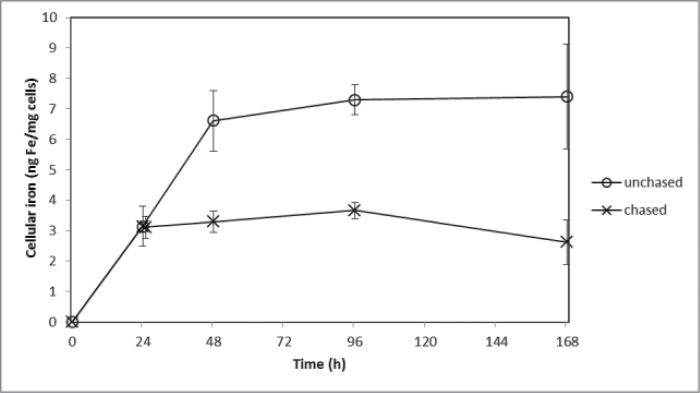

55Fe uptake (internalized Fe) after washing with the Ti reagent as a function of time by E. siliculosus treated with 30 μM 55FeEDTA or following a chase of 30 μM 56FeEDTA. The chase was added at the 24-h time point. Data are mean ± standard deviation of triplicate measurements.